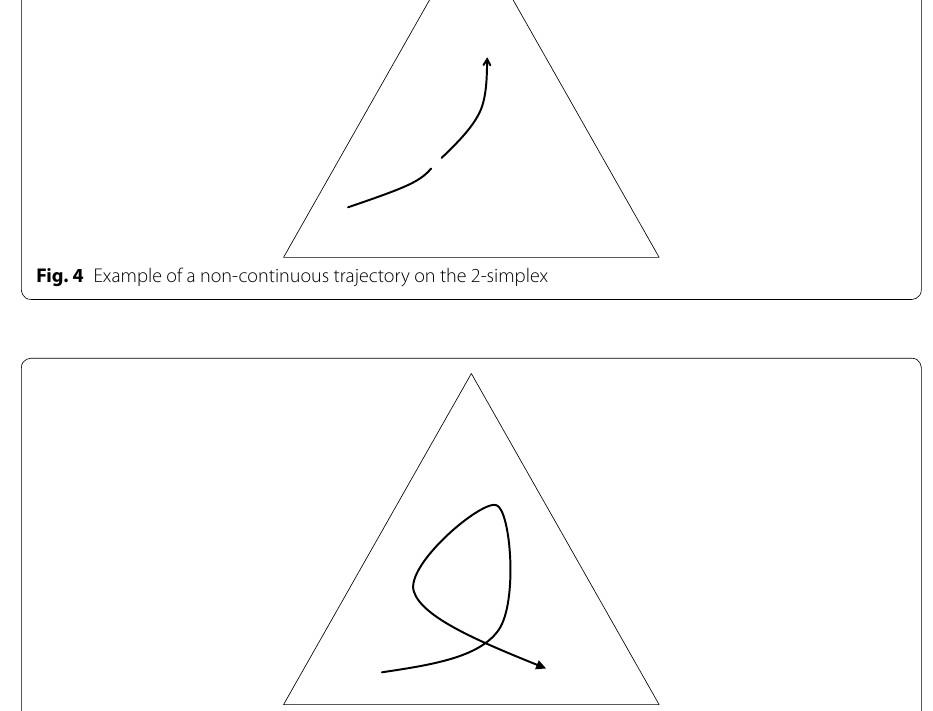
Fig. 5 Example of a self-intersecting (and continuous) trajectory on the